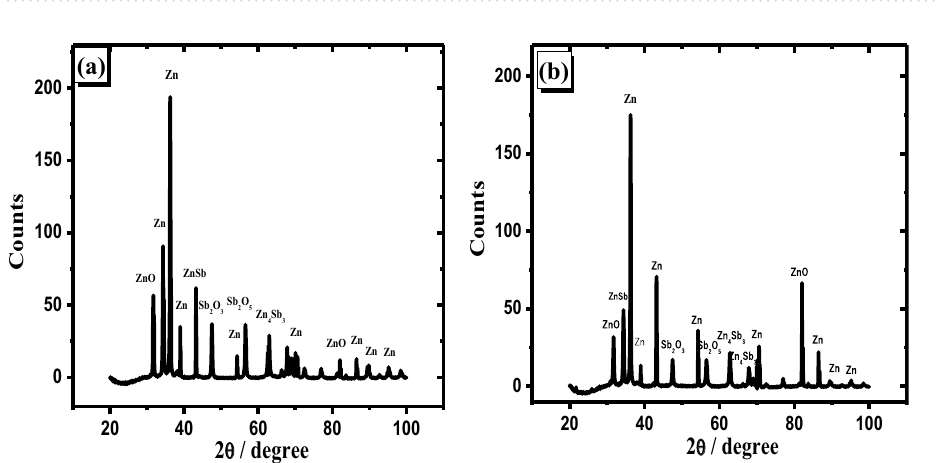
Figure 9. XRD examination of the oxide film generated anodically at the trans-passive potential + 2.0 V on alloy I ( a ) and alloy II ( b ) in 6 M KOH at 25